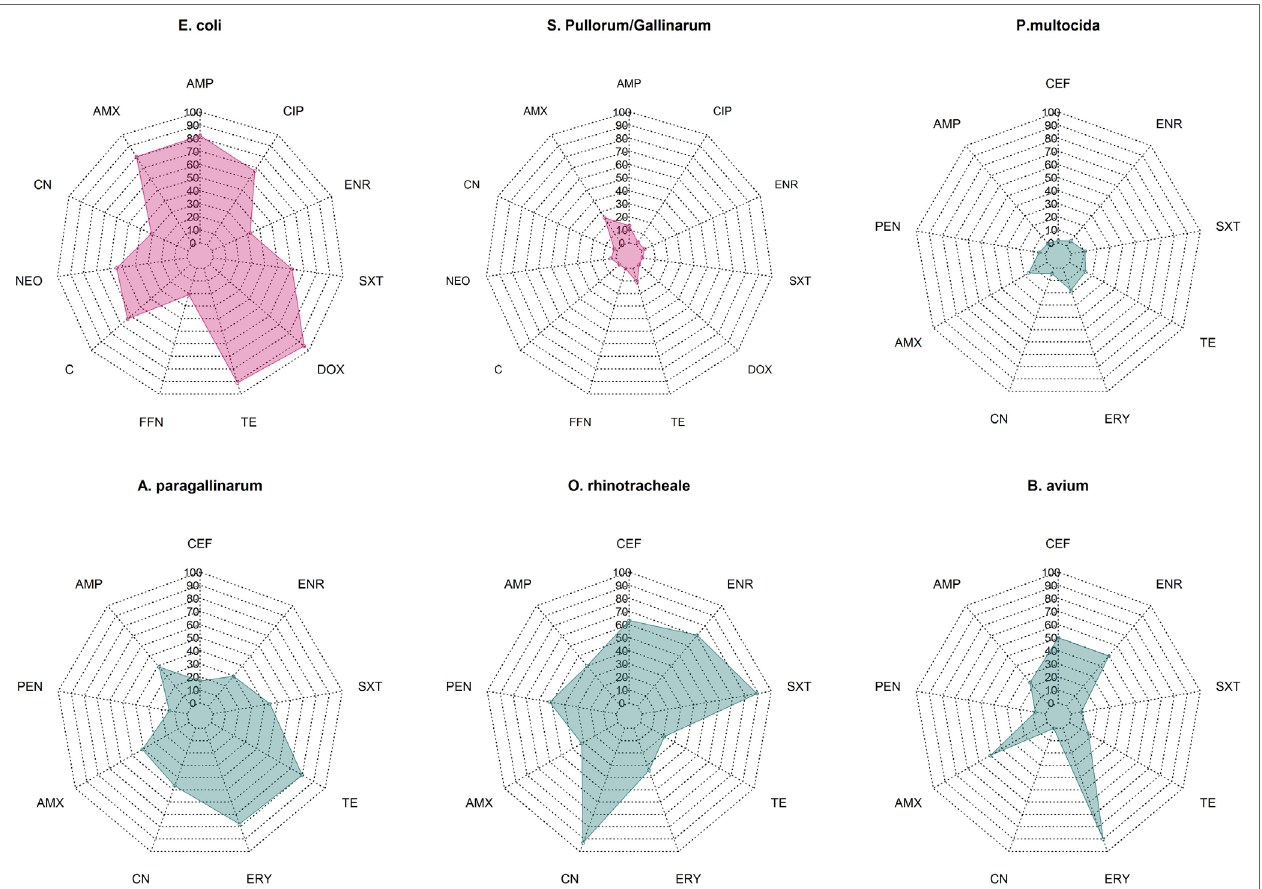
FiGURe 1 | Summary data on prevalence of phenotypic resistance among in common bacterial poultry pathogens ( E. coli, S. pullorum/gallinarum, P. multocida, A. paragallinarum, O. rhinotracheale, and B. avium ). AMC, amoxicillin/clavulanic acid; AMP, ampicillin; C, chloramphenicol; CEF, ceftiofur; CIP, ciprofloxacin; CN, gentamicin; DOX, doxycycline; ENR, enrofloxacin, ERY, erythromycin; FFN, florfenicol; NEO, neomycin; PEN, penicillin; SXT, co-trimoxazole; TE,